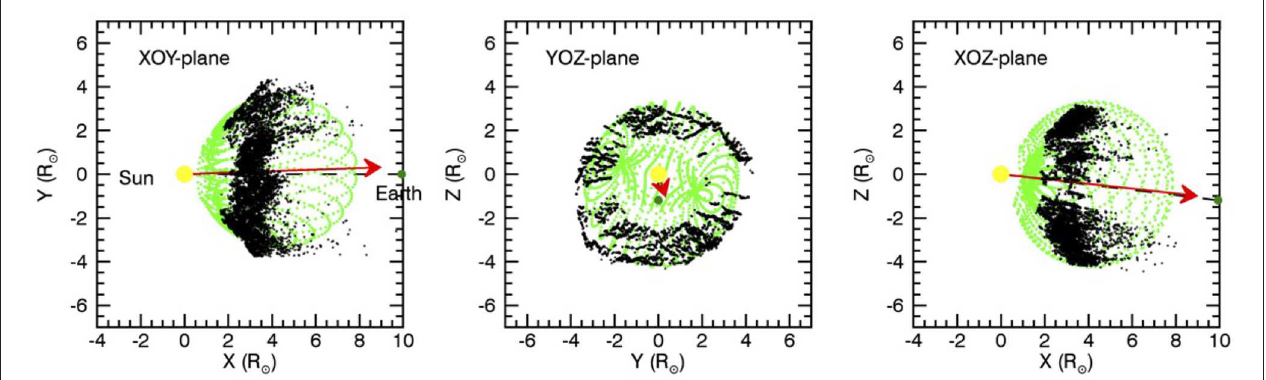
FIGURE 2 | Projections of the reconstructed CME with the GCS-PR method onto different planes. The red arrows indicate the direction from the Sun to the center of the GCS reconstructed CME. This figure is adapted from Lu et al. [54].